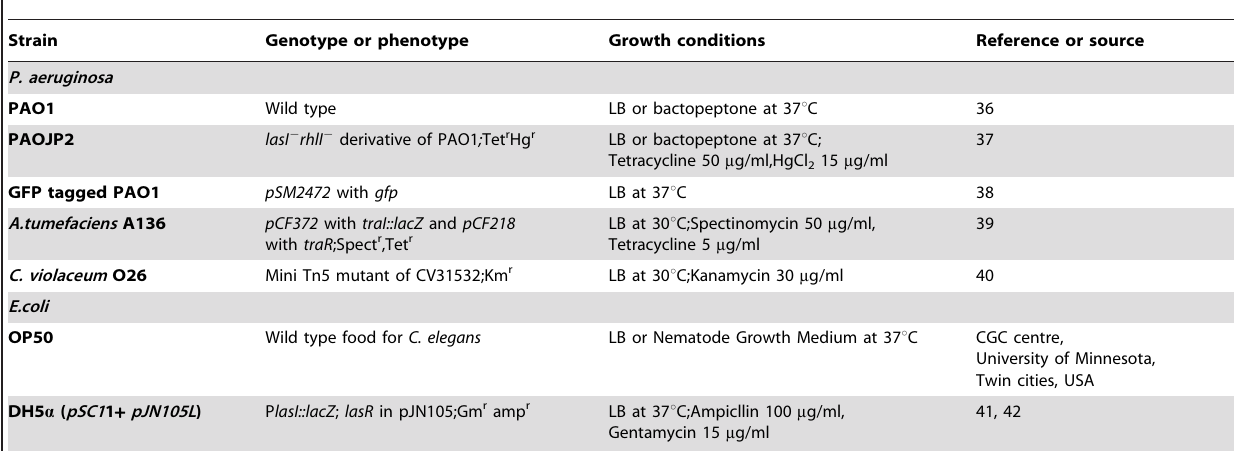
Table 1. Bacterial strains and plasmids used in this study.